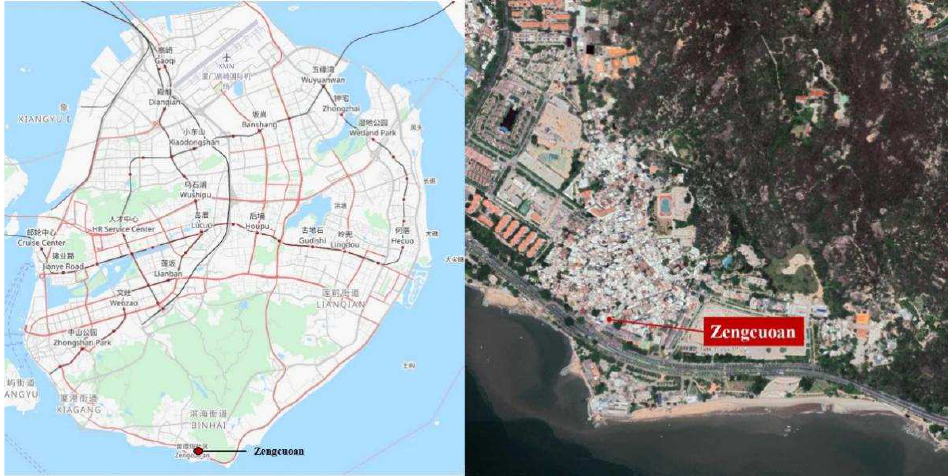
Figure 3. The location of Zengcuoan in Xiamen city. Source: Adapted by the authors from Open- StreetMap and Google Earth.